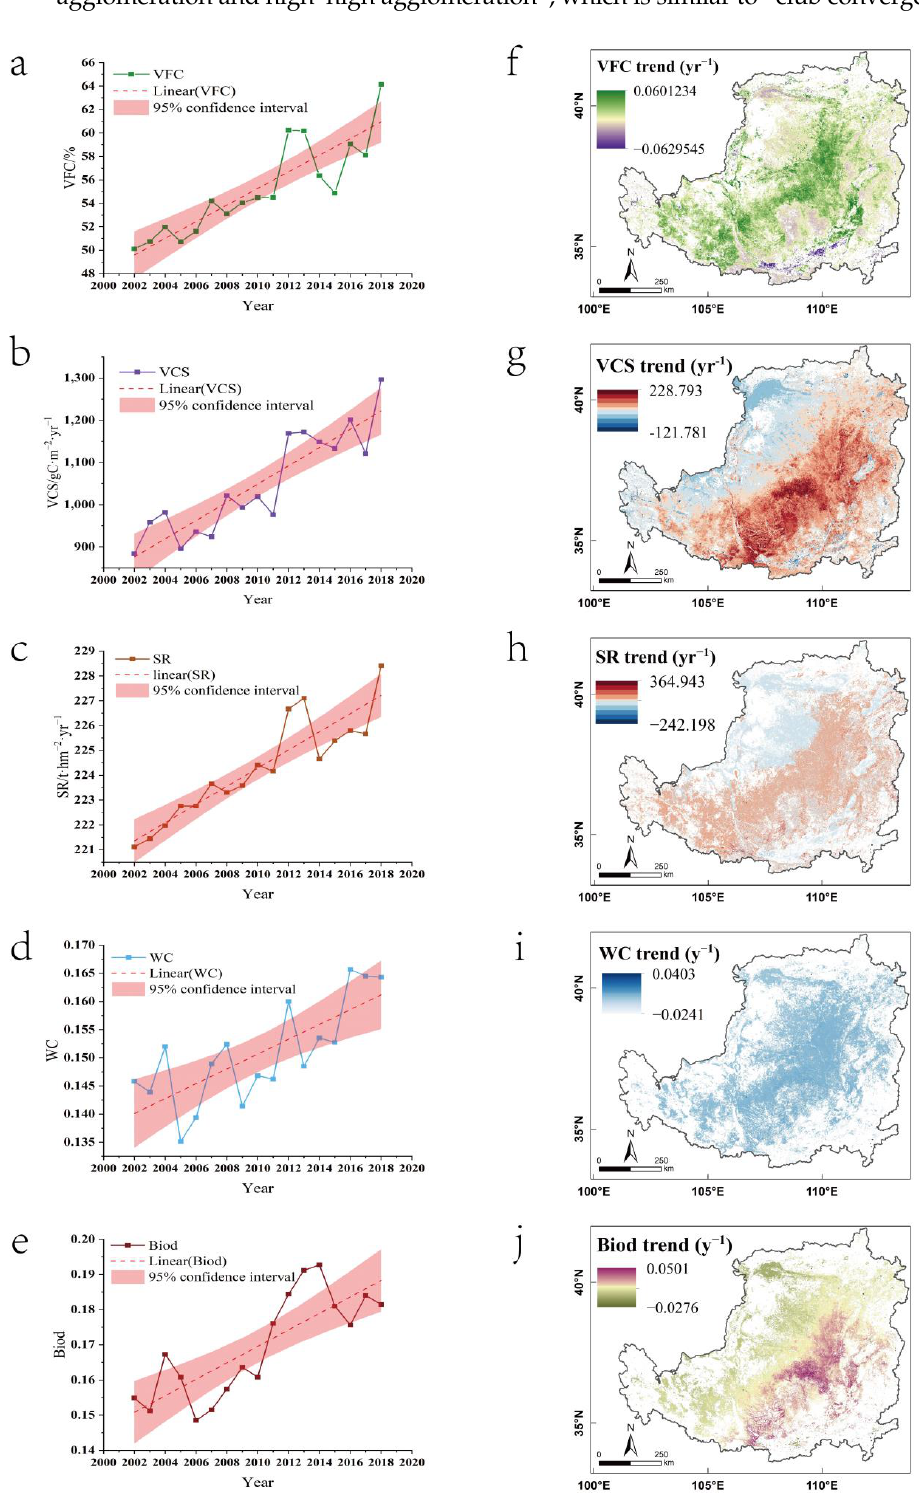
Figure 3. Variation of ( a ) VFC, ( b ) VCS, ( c ) SR, ( d ) WC, and ( e ) Biod from 2002 to 2018; ( f ) VFC, ( g ) VCS, ( h ) SR, ( i ) WC, and ( j ) Biod have changed significantly ( p < 0.05) from 2002 to